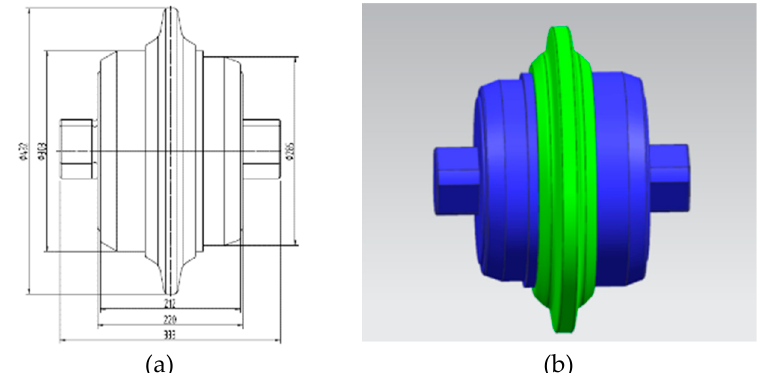
Figure 3. Seventeen-inch cutter: ( a ) two-dimensional drawing; and ( b ) three-dimensional model.